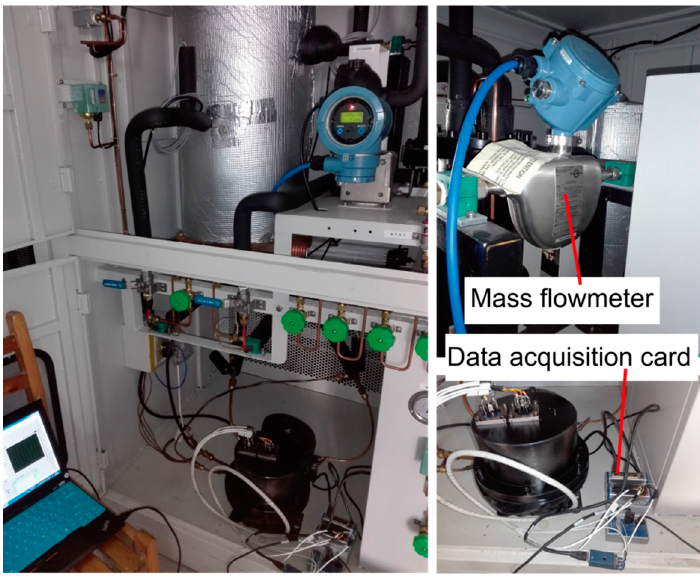
Figure 3. Test facility for the refrigeration system.